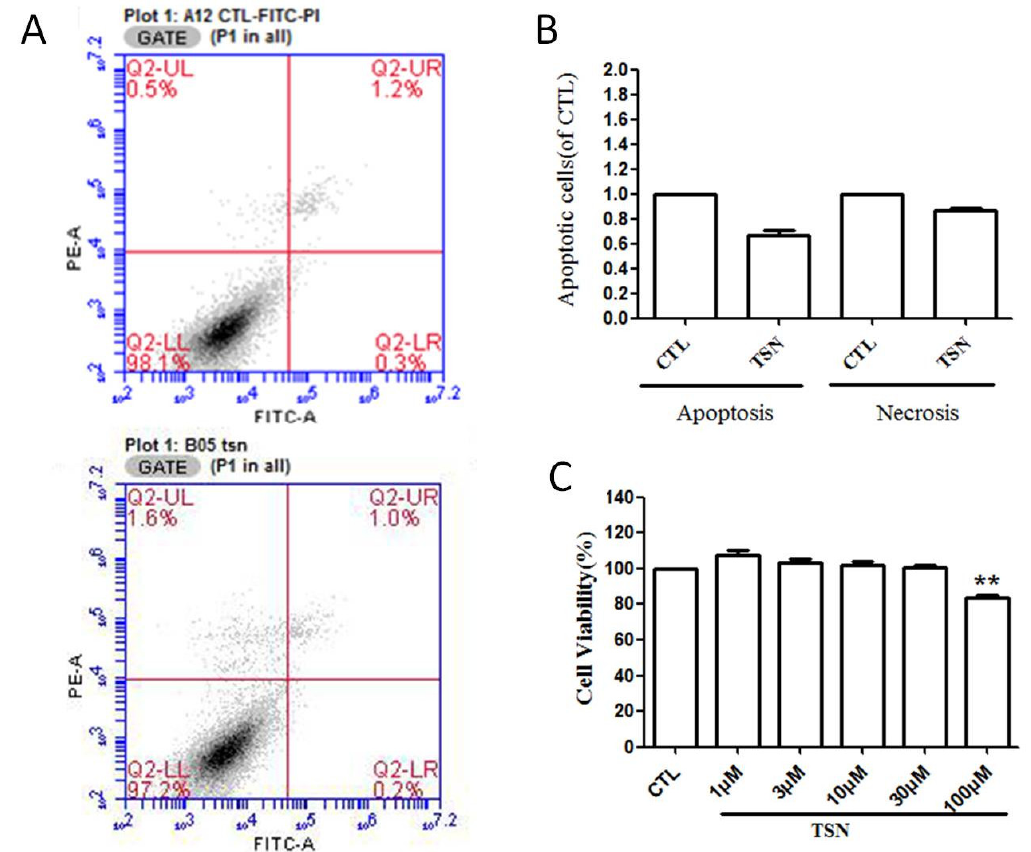
Figure 2. TSN had no effect on cell apoptosis in PC12 cells. Cells were pretreated with or without TSN (20 µ M) for 24 h. The apoptosis of PC12 cells was determined by flow cytometry. ( A ) Photographs of representative cultures measured by Flow cytometry; ( B ) Quantification of apoptotic cells; ( C ) PC12 cells were treated with various concentrations (1–100 µ M) of TSN for 24 h and cell viability was measured using MTT assay. The values were expressed as mean ± SEM. ** p < 0.01, compared with control. CTL, control.